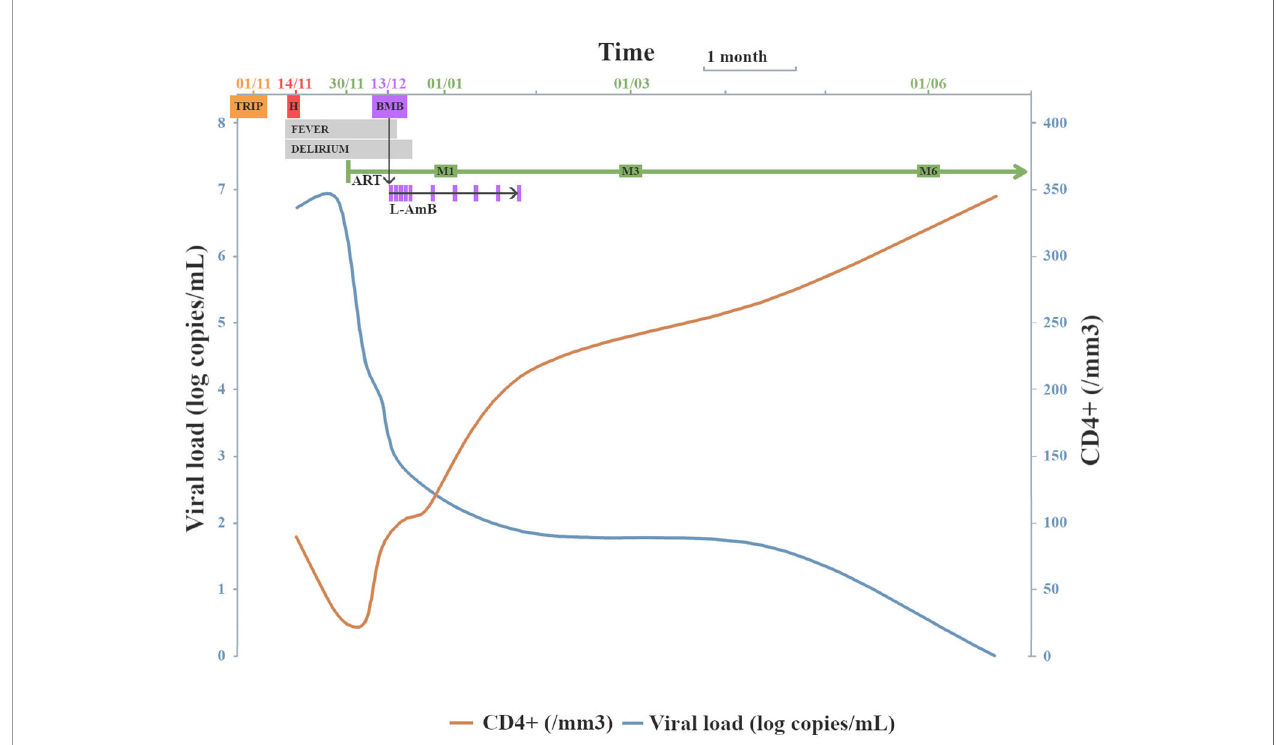
FIGURE 2 | Viral load and CD4 + T-cells count evolution following cART initiation and VL diagnosis. TRIP = travel in Greece; H = date of hospitalization; (c)ART = (combined) anti-retroviral therapy; BMB = bone marrow biopsy (VL diagnosis); M1 = fi rst month after cART initiation; M3 = third month after cART initiation; M6 = sixth month after cART initiation; LAmB = intravenous liposomal amphotericin B